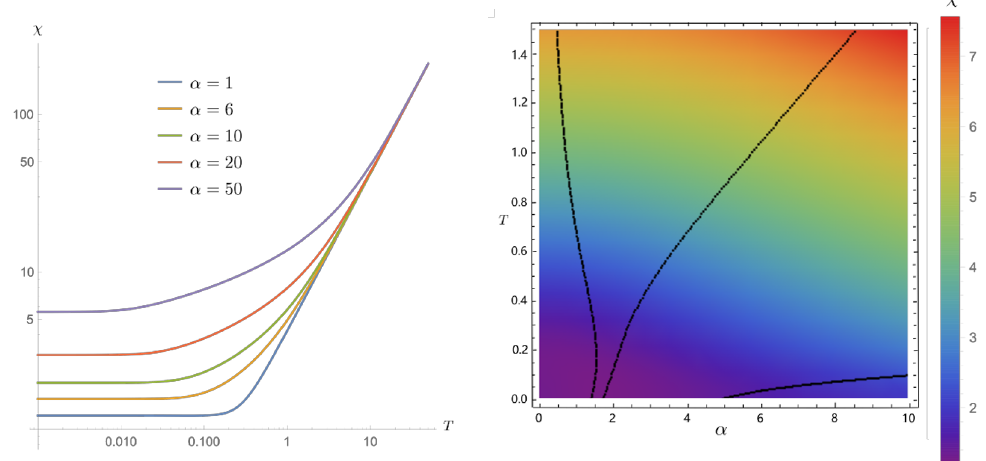
Figure 14 . Static charge susceptibility (cid:31) for the Linear model (3.23) at zero magnetic (cid:12)eld. The behavior of (cid:31) as a function of T is present in the left plot, and the density plot of (cid:31) in the temperature-disorder plane is shown in the right plot. Black dotted lines denote the phase boundaries of metallic and insulating phases of (cid:12)gure 11. We have (cid:12)xed K = (cid:0) 1 = 6 and (cid:26) =